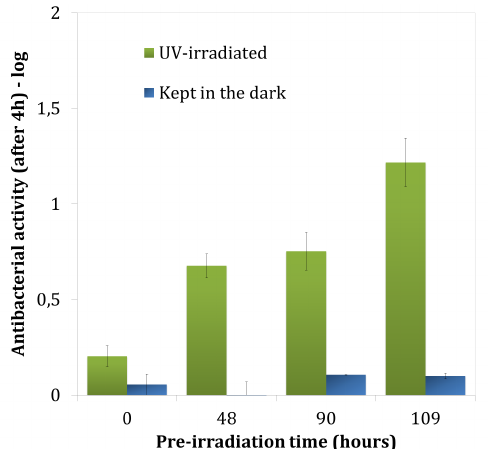
Figure 3. Antibacterial activity of TiO 2 -coating on E. coli after 4 h of test, depending on the time of pre-irradiation of the coating (3 W/m 2 ). Mean ± s.e., n =